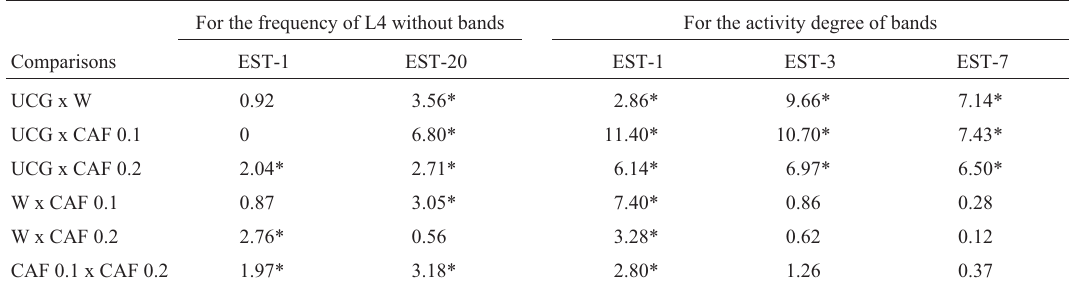
Table 6 - Two by two multiple comparisons of proportions, for frequencies of L4 not expressing the bands EST-1 and EST-20 and for activity degree of bands EST-1, EST-3 and EST-7, p ≤ 0.05. W = water; UCG = used coffee grounds at 25 mg/mL; CAF 0.1 = caffeine at 0.1 mg/mL; CAF 0.2 = caffeine at 0.2 mg/mL.